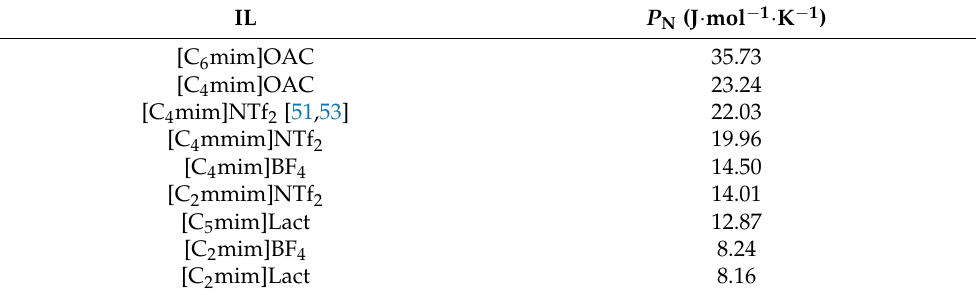
Table 6. Polarity of various ionic liquids estimated using the P N scale.